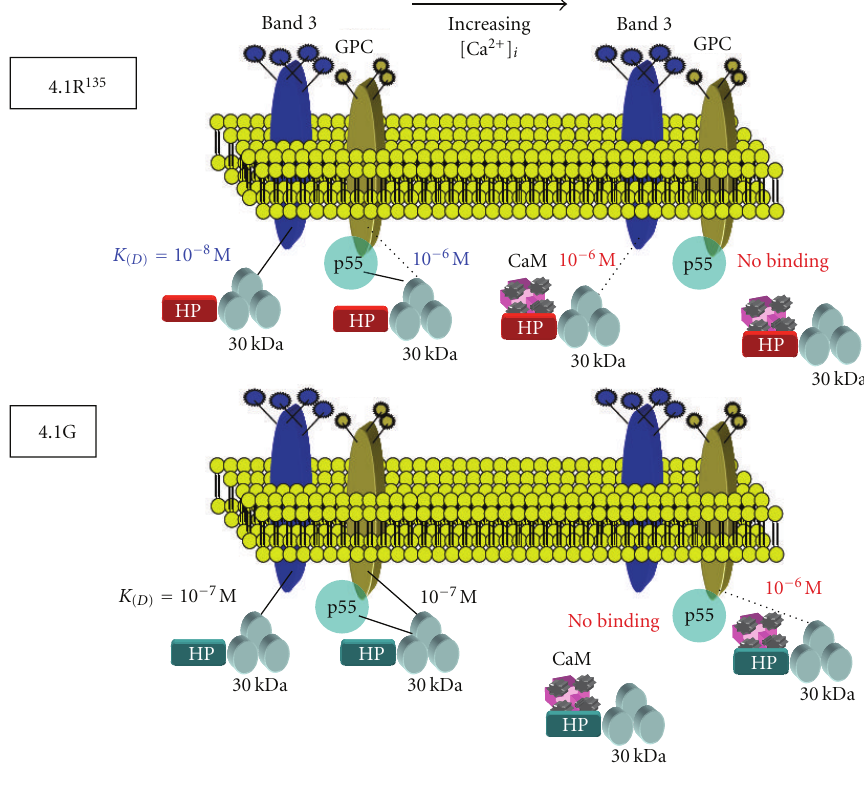
Figure 9: Model proposed for Ca 2+ /CaM-dependent regulation of 4.1G binding to membrane proteins. Erythroblast intracellular Ca 2+ concentration is normally maintained at less than 0.1 μ M (10 − 7 M) as described in Figure 7 [39, 40]. 4.1G binds to band 3, GPC and p55 with a K ( D ) of 10 − 7 M. At higher Ca 2+ concentrations, CaM binds to the HP region with a K ( D ) of 10 − 8 M. This results in a conformational and/or electric surface change which alters 4.1G binding sites, 4.1G interacting consequently with lower a ffi nity with its binding partners GPC and no longer interacting with band 3 and p55. This model implies a Ca 2+ /CaM-dependent regulation of 4.1G binding to transmembrane